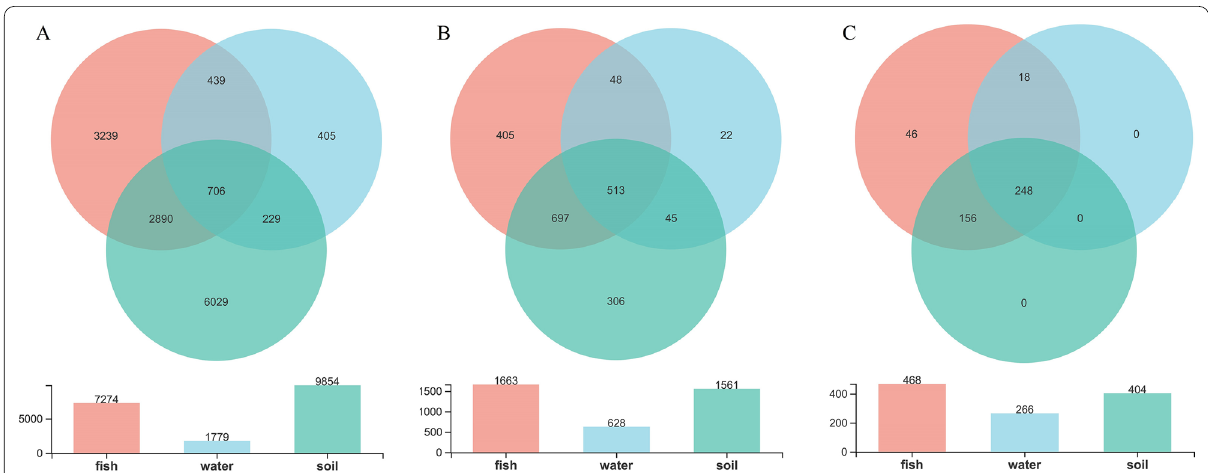
Fig. 2 Venn diagrams showing the number of shared bacterial OTUs A and genera B in planktonic, intestinal and soil bacterial communities, and that the shared intestinal bacterial genera by the five carp species were also found in soil C . Fish, water and soil indicating intestinal, planktonic and soil bacterial